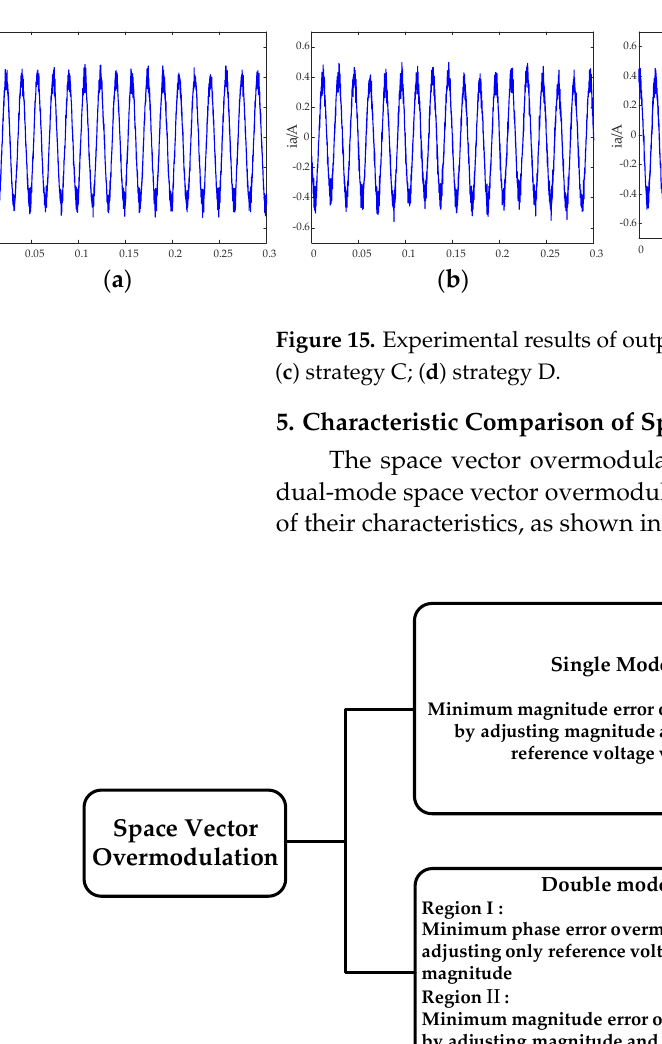
( d ) Figure 13. Fourier transform results of output phase voltage harmonic at m = 0.909: ( a ) strategy A; ( b ) strategy B; ( c ) strategy C; ( d ) strategy D. The experimental results of the fifth and seventh harmonic components are shown in Figure 14. When 0.866 < m ≤ 0.909, the fifth and seventh harmonic components of strategies A and C were less than 3%, and the fifth and seventh harmonic components of strategies B and D were far greater than those of strategies A and C. Compared with Figure 9, the results were basically consistent. In addition, the phase current waveform of the motor is shown in Figure 15. It is clear that the current harmonic components of strategies B and D also exceed those of strategies A and C. Therefore, the correctness of the theoretical anal ‐ ysis was verified through these experiments.